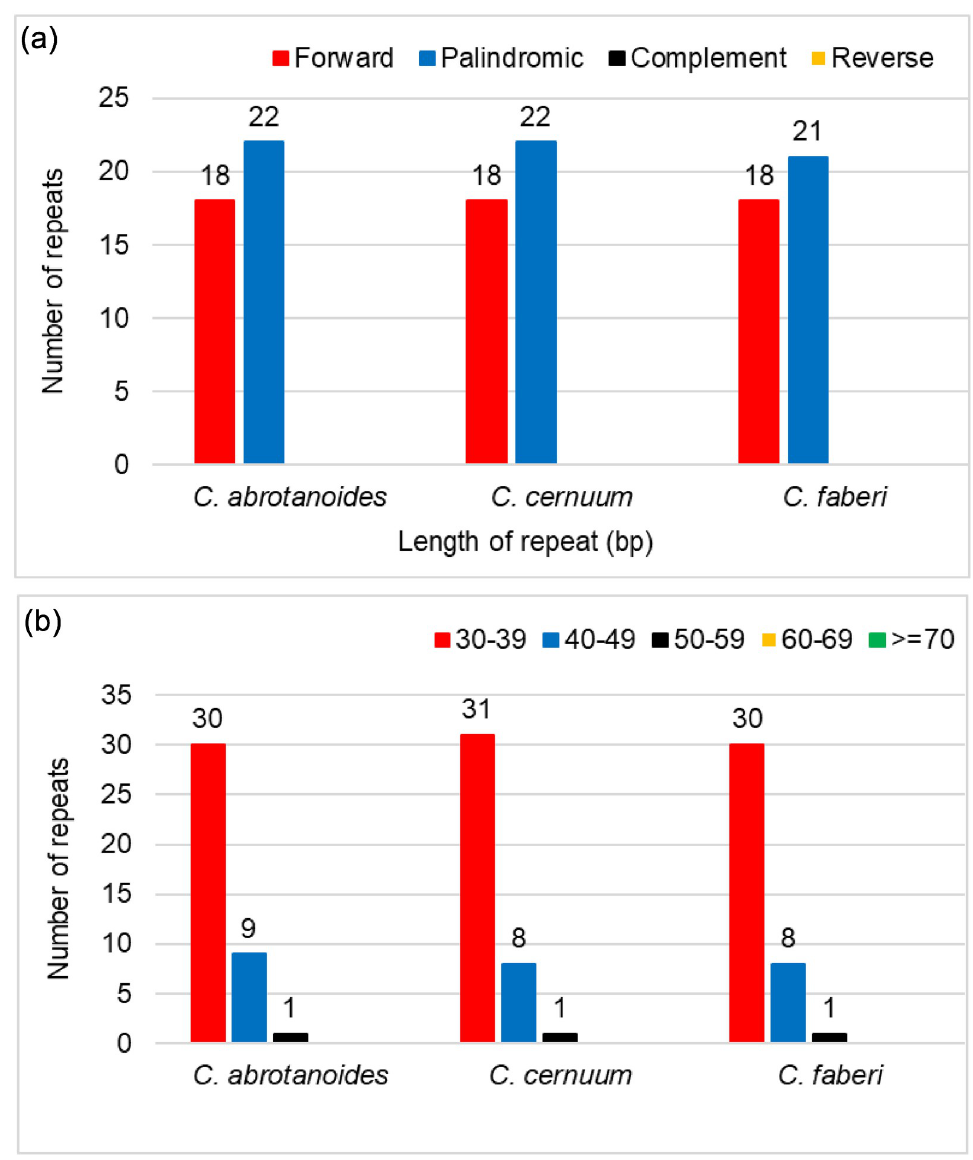
Fig 4. Repeat sequences in the cp genomes of three Carpesium species. (a) Repeat sequence types and number of repeats. (b) Number of repeat sequences of different